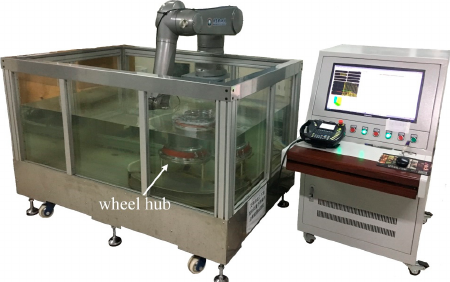
Figure 5. Overview of the robot-assisted UT system. Table 1. Main components of the robot-assisted UT system.